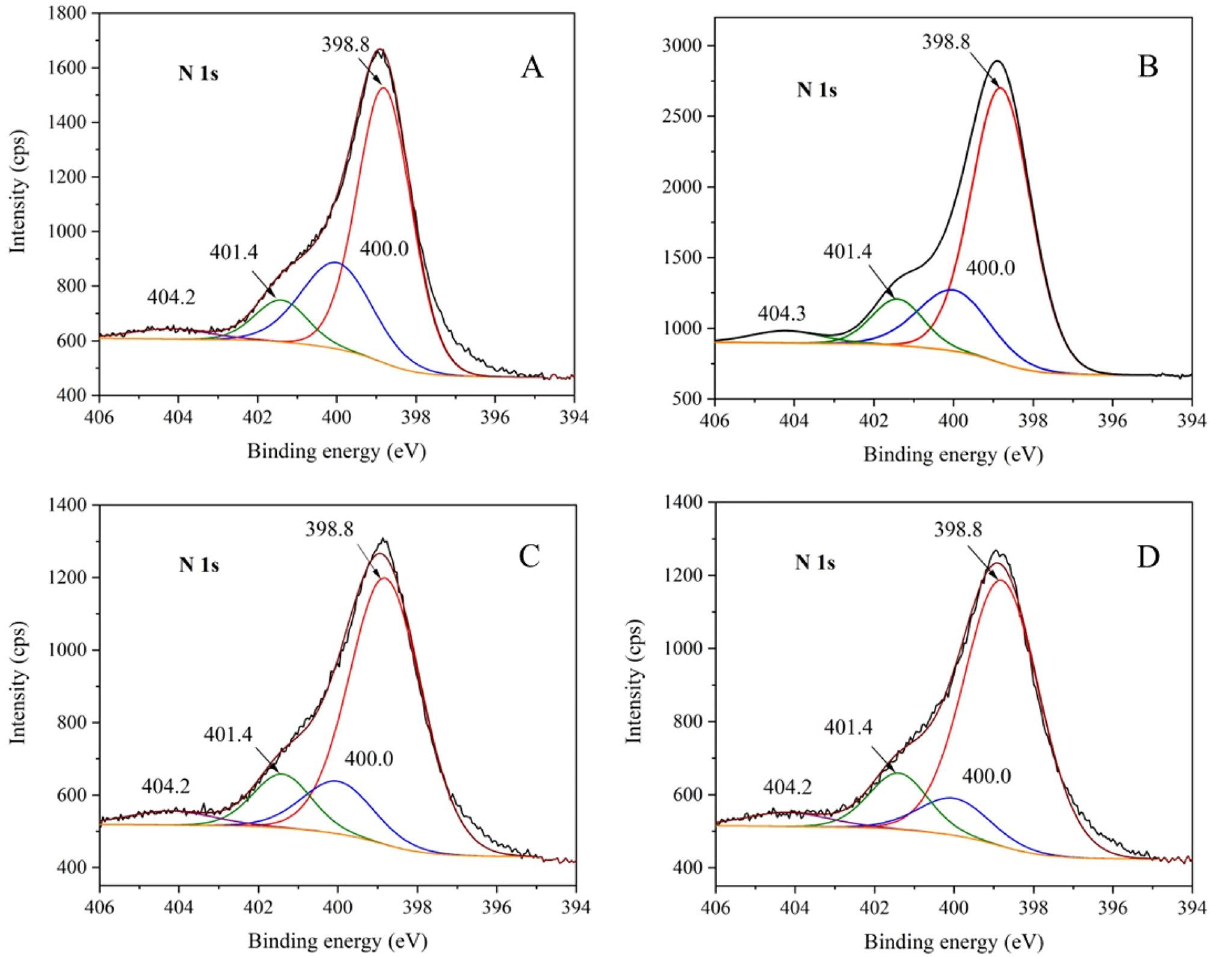
Figure 7. XPS N 1s spectra of C 3 N 4 synthesised in air and argon. ( A ) CN, ( B ) CN-3, ( C ) CN-Ar0, and ( D ) CN-Ar3.